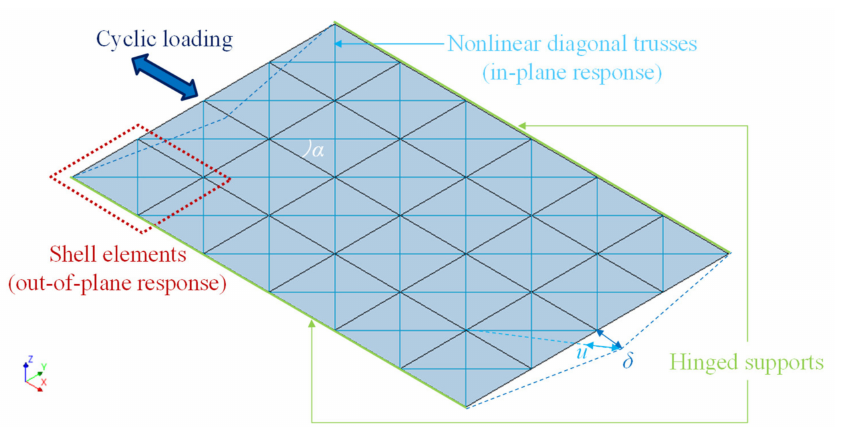
Figure 5. Example of model of a retrofitted diaphragm created for validating the modeling strategy presented in Reference [41] (Reprinted from Reference